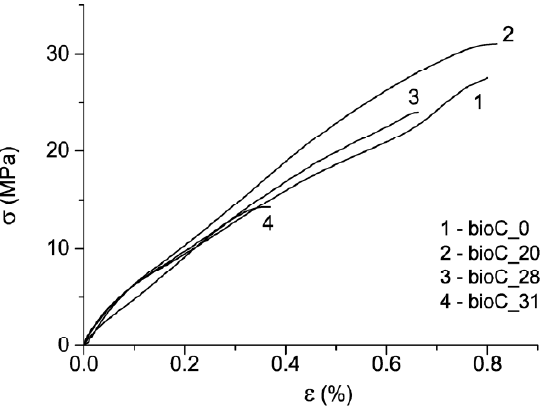
Fig. 4. Stress-strain curves obtained in compres- sion for non-activated and activated biocarbon mono- liths.